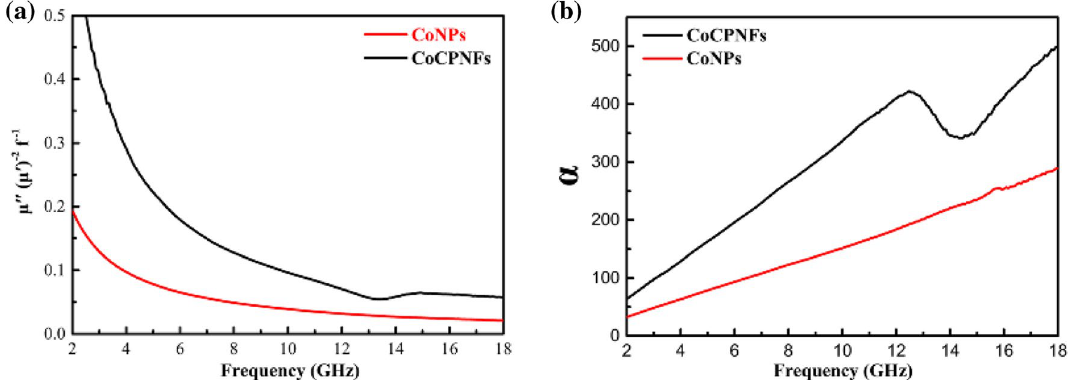
Figure 8. ( a ) The values of μ ″ (μ ′ ) −2 f −1 and ( b ) the values of attenuation constant (α) versus the frequency for Co/ PCNF and